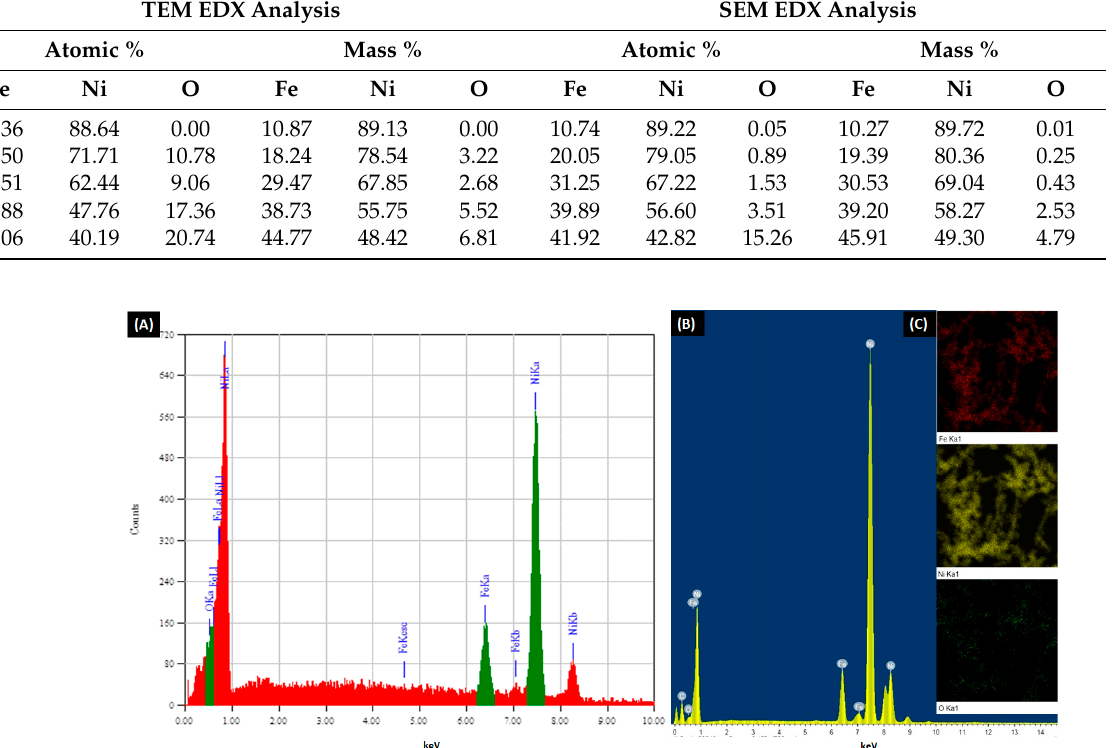
Figure 6. EDX analysis of the synthesized Fe 10 Ni 90 alloy using ( A ) SEM and ( B ) TEM. ( C ) TEM mapping of the alloy. Reaction reference: 0.1 M metal concentration, 80 mL reaction volume, 1400 rpm, and 95–98 °C.